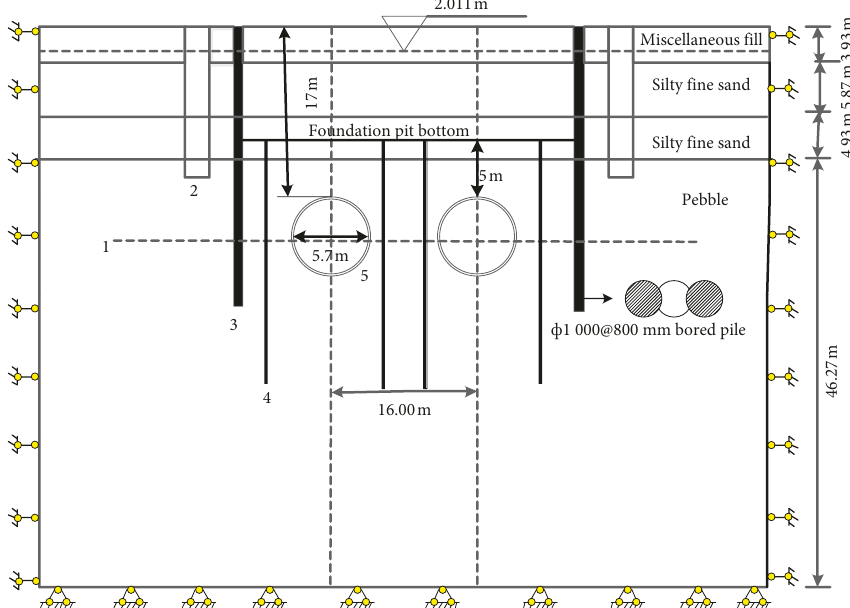
Figure 2: Relative position profile of strata and dewatering well.1. Left and right tunnel centerline. 2. Dewatering well. 3. Diaphragm wall. 4. Uplift pile. 5. Existing tunnel.